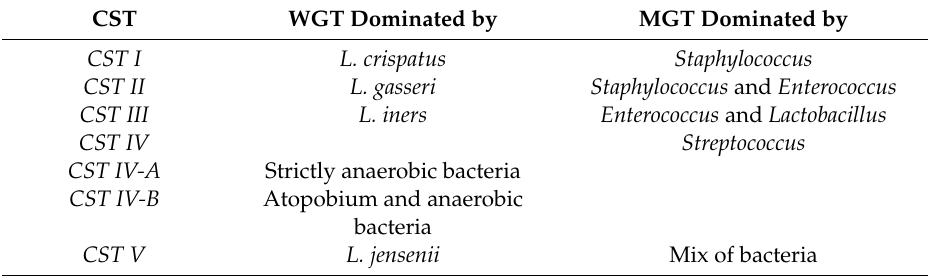
Table 2. Community state type (CST) of the woman (10 7 –10 9 bacteria) [71,72] and the mouse genital